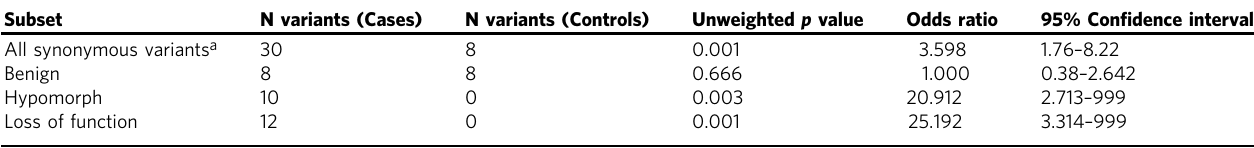
Table 4 Meta-analysis of both cohorts, Gene-based association of PCM1 and ASZ using ultra-rare functional variants. Subset N variants (Cases) N variants (Controls) All synonymous variants